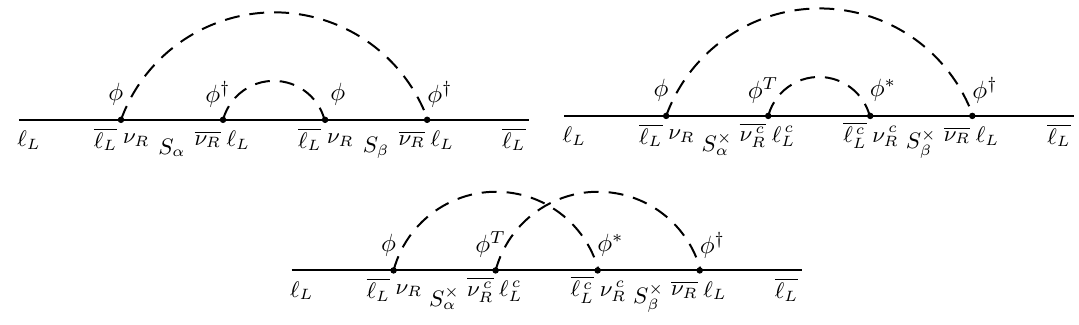
Figure 3 . Two-loop self-energy diagrams for the light (cid:23) L neutrinos giving rise to a lepton-antilepton asymmetry in curved